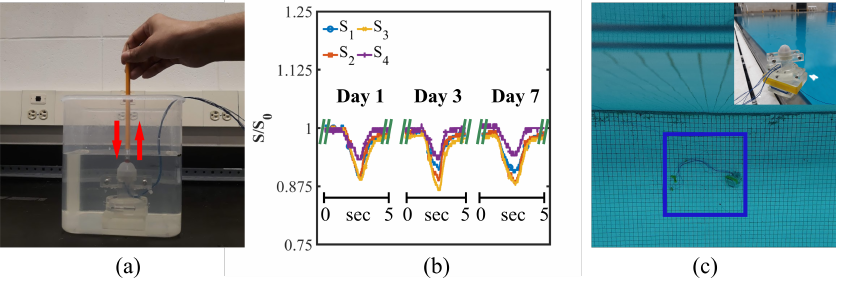
Figure 15. Waterproofing test for the sensor: ( a ) exerting and retracting vertical force (depicted by the red arrows) underwater, ( b ) corresponding reading changes of the sensor, and ( c ) sensor being submerged at 13 ft ( ∼ 4 m) depth (inset image shows the sensor being held by a custom made